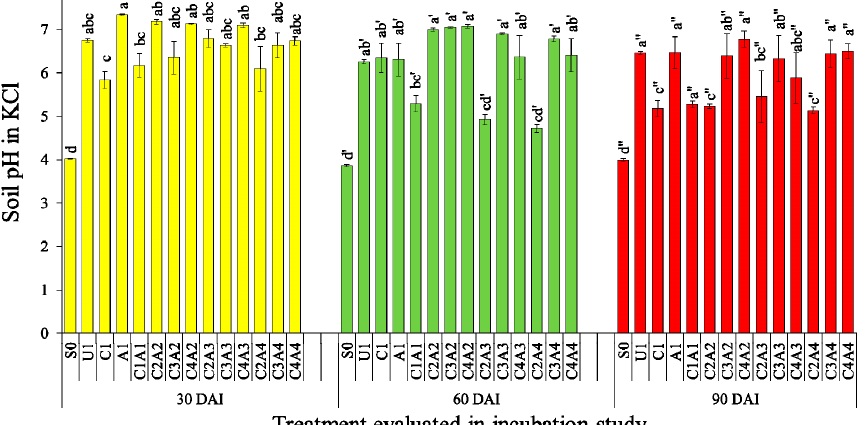
Figure 3. Treatments on soil pH in potassium chloride after thirty, sixty, and ninety days of incubation. Means with different letter(s) within the same incubation period indicate significant difference between treatments by Tukey’s HSD test at p ≤ 0.05. Bars represent the mean values ±